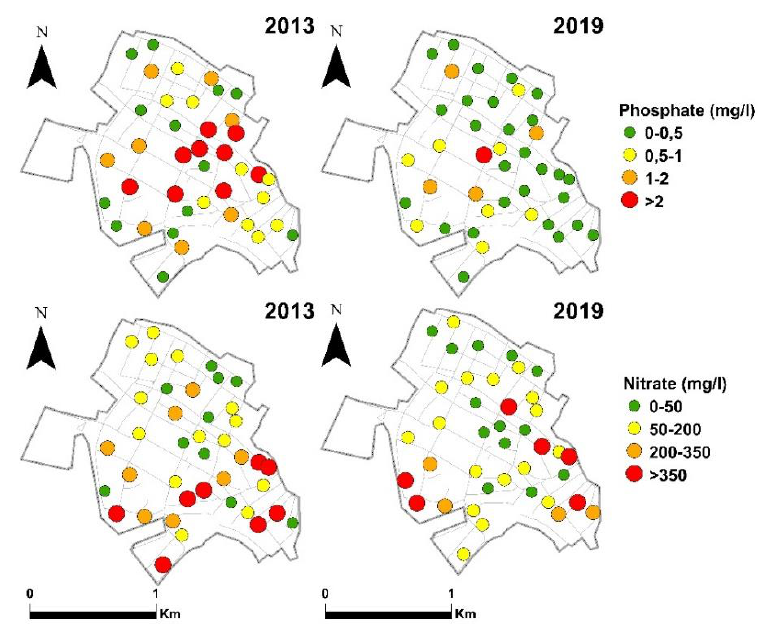
Figure 3. Spatial distribution of phosphate and nitrate values in the investigated wells.